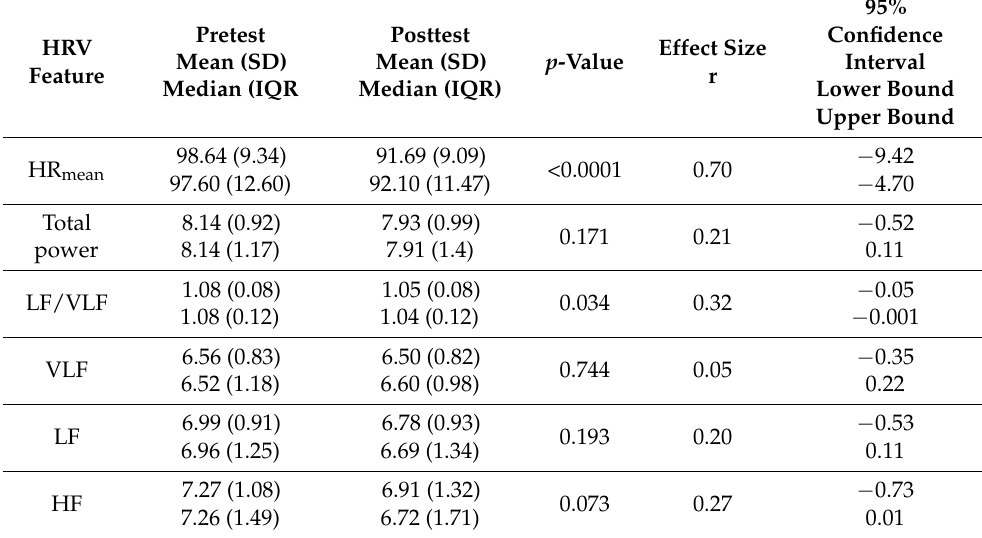
Table 4. The HRV statistical results for the pretest and posttest condition.